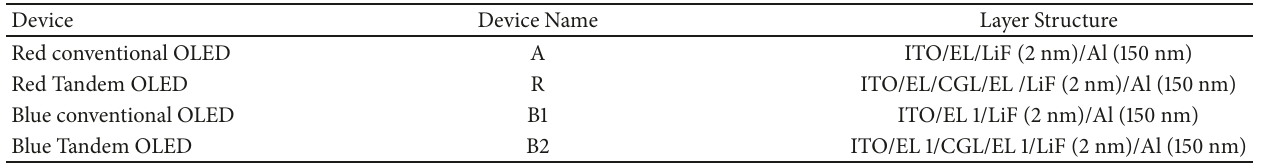
Table 1: The detail device structures of red and blue